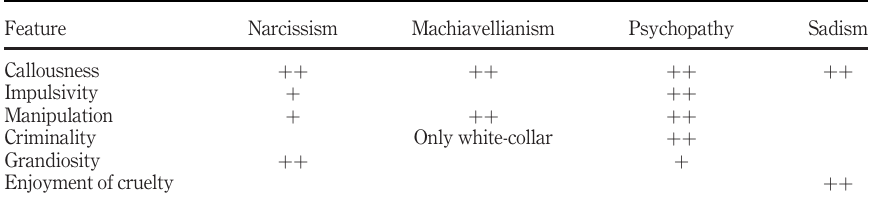
Table I. Key features of the “ Dark Tetrad